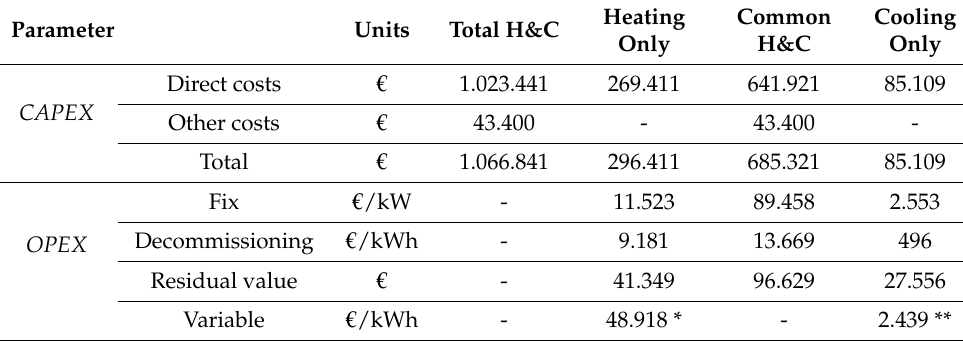
Table A3. Economic